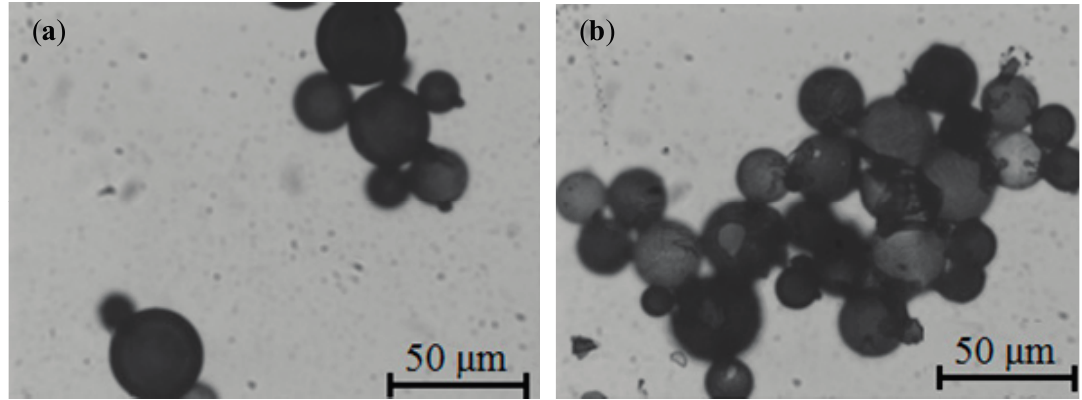
Figure 3. Optical micrographs depicting NMBs captured on glass slides in a